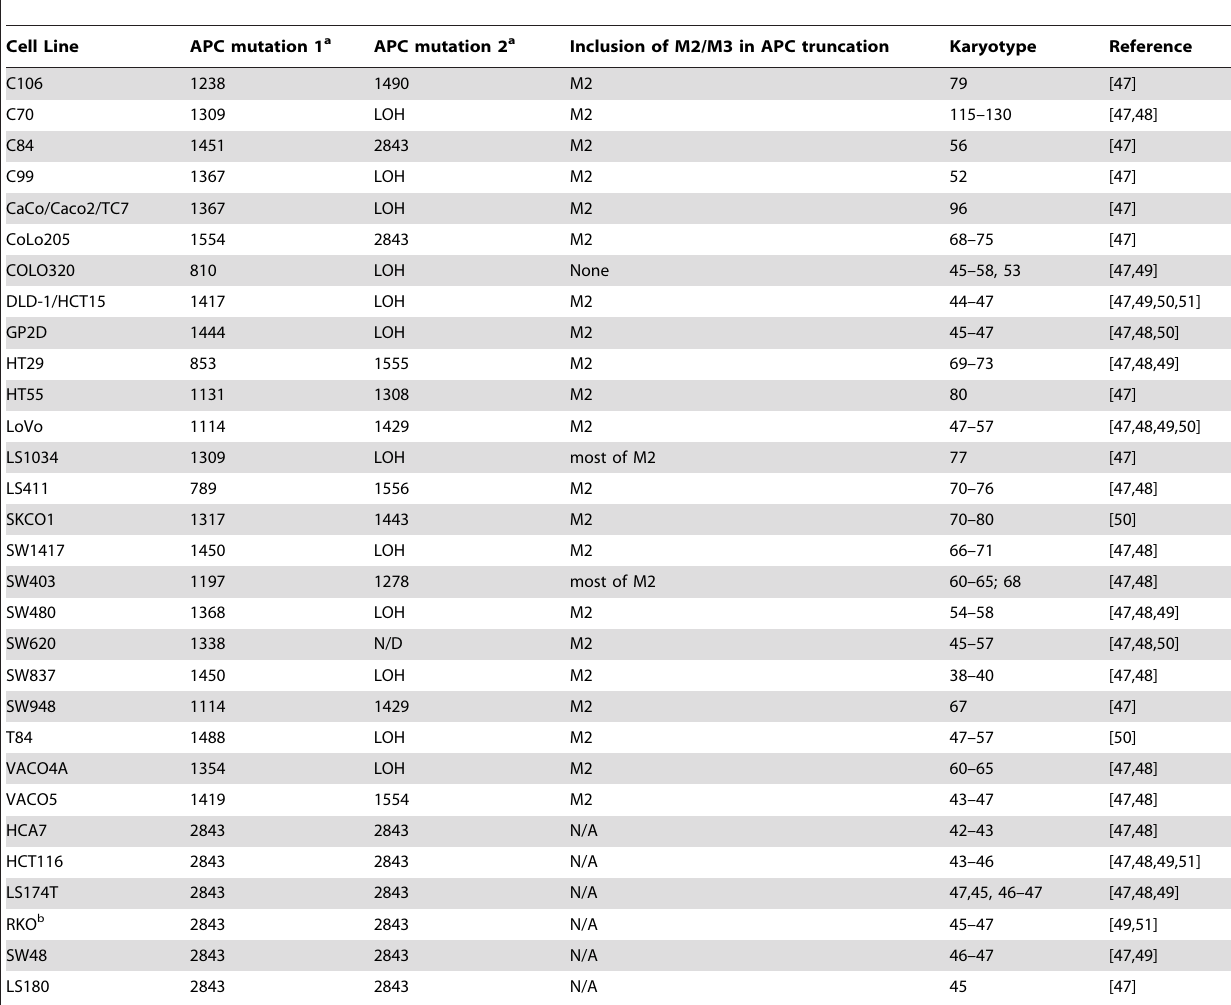
Table 1. Correlation of karyotype with APC status and presence of M2 and M3-APC in some commonly used colorectal cancer cell